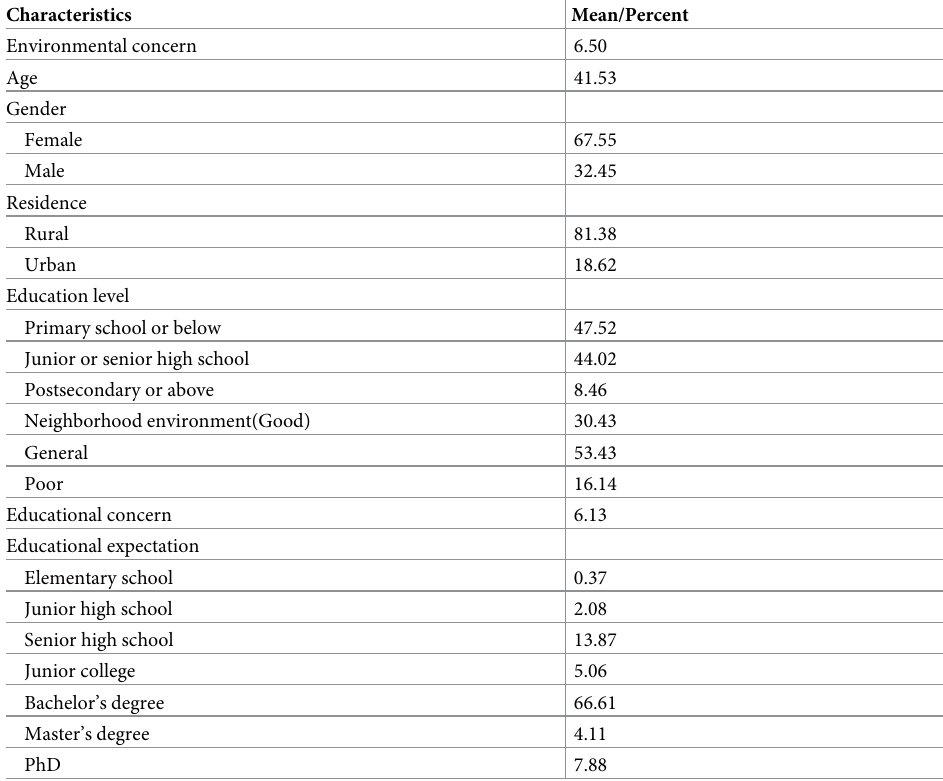
Table 1. Population characteristics.